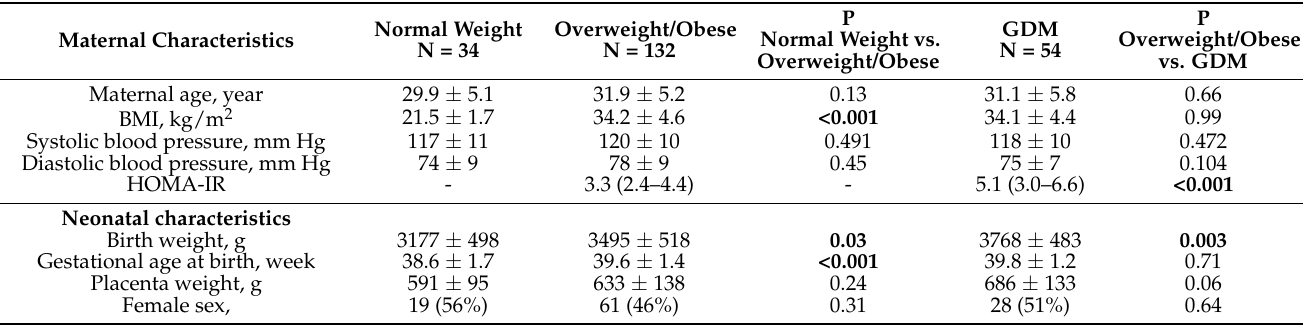
Table 1. Clinical characteristics of study cohort. Data are presented as mean and standard deviation, median and interquartile range, or as count and proportion. Differences between normal-weight and overweight/obese subjects, as well as comparisons between obese and GDM groups, were calculated: BMI, body mass index; GDM, gestational diabetes